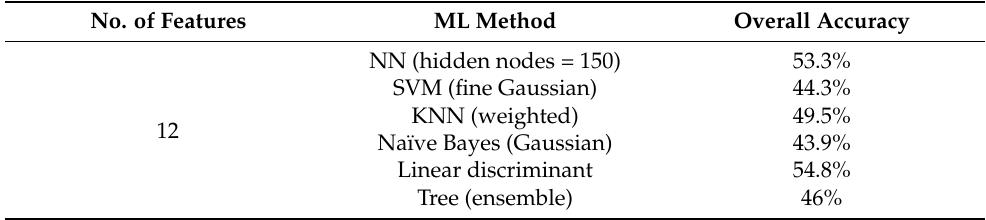
Table 3. Performance of the best OST prediction systems, using radiomic features based on mid- sagittal plane and various ML methods.